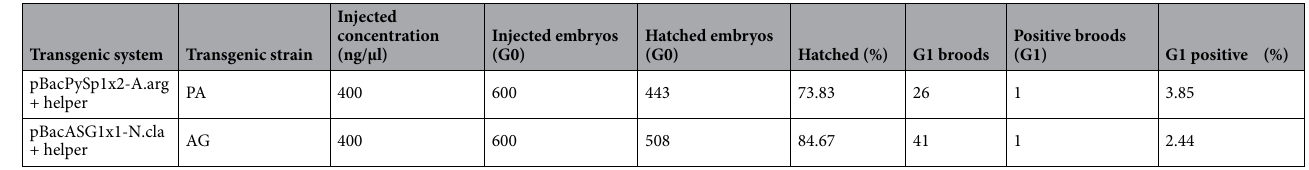
Table 1. Microinjection into embryos of the Lan10 strain.